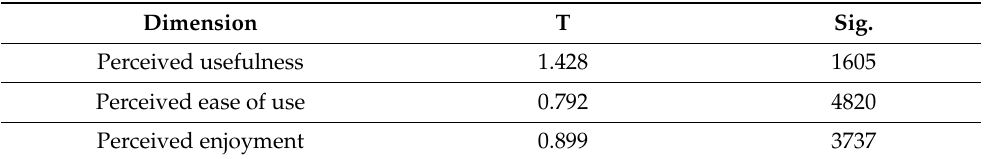
Table 7. Student’s t for the gender variable and the TAM dimensions “Perceived Usefulness,” “Perceived Ease of Use,” and “Perceived enjoyment”.